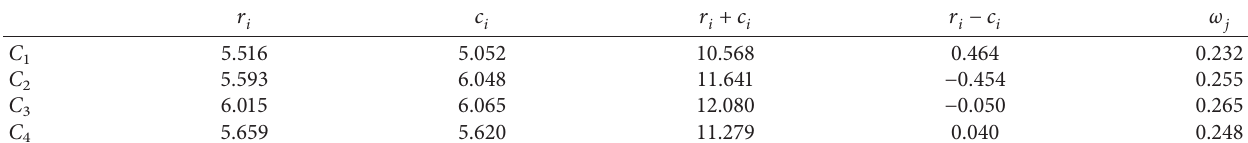
c r + c r − c i i , i i , i i , and ω j .